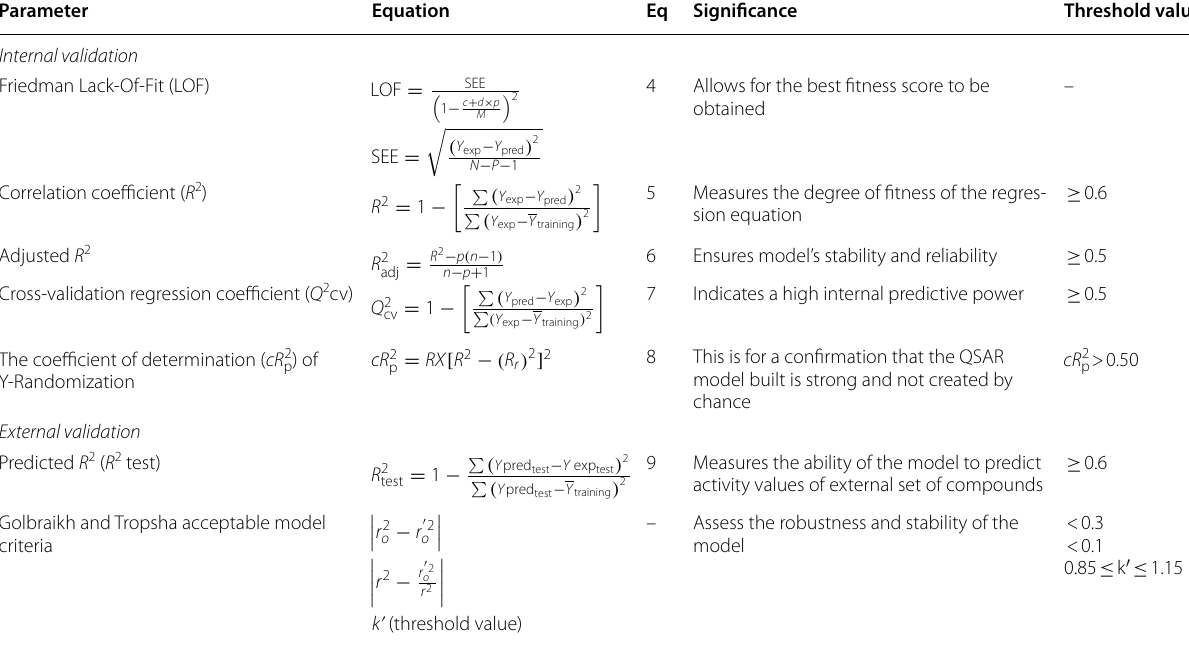
Table 2 Some equations and parameters used for the model